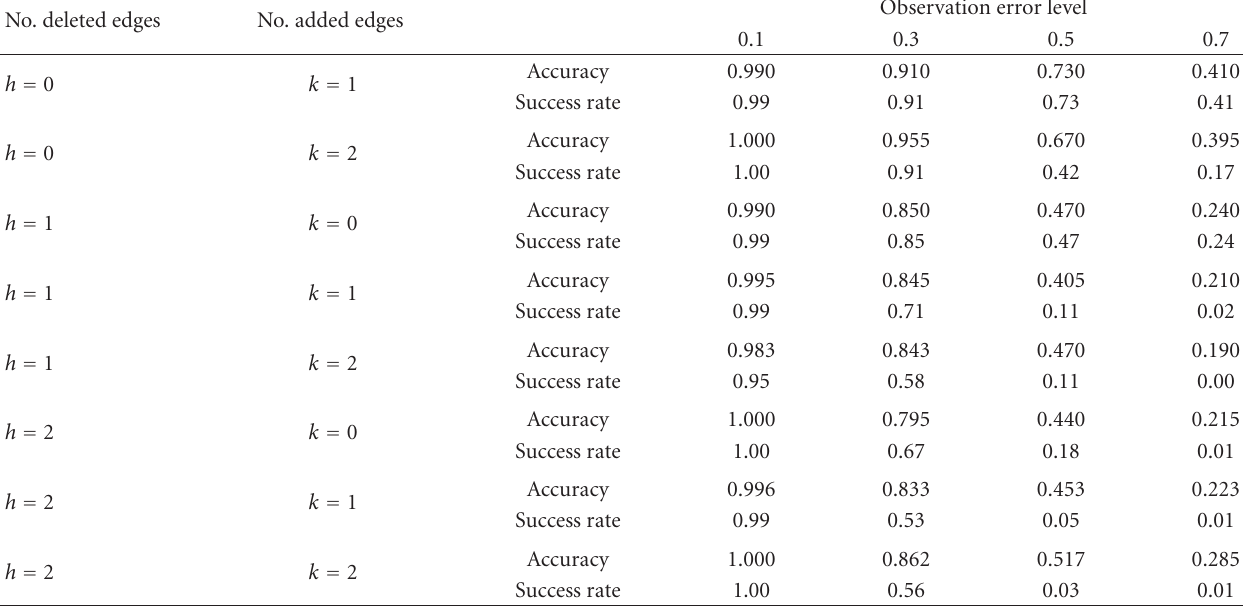
Table 1: Result on completion of WNT5A network, where the average accuracy is shown for each case.